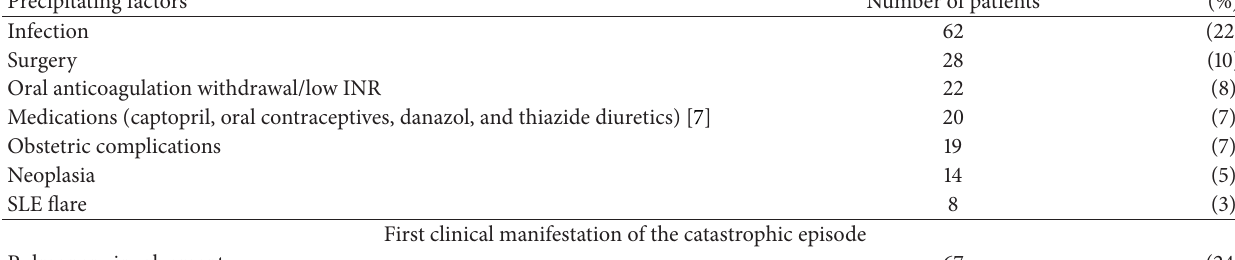
Table 1: Precipitating factors and clinical manifestations of 280 patients with catastrophic APS from the CAPS registry. Precipitating